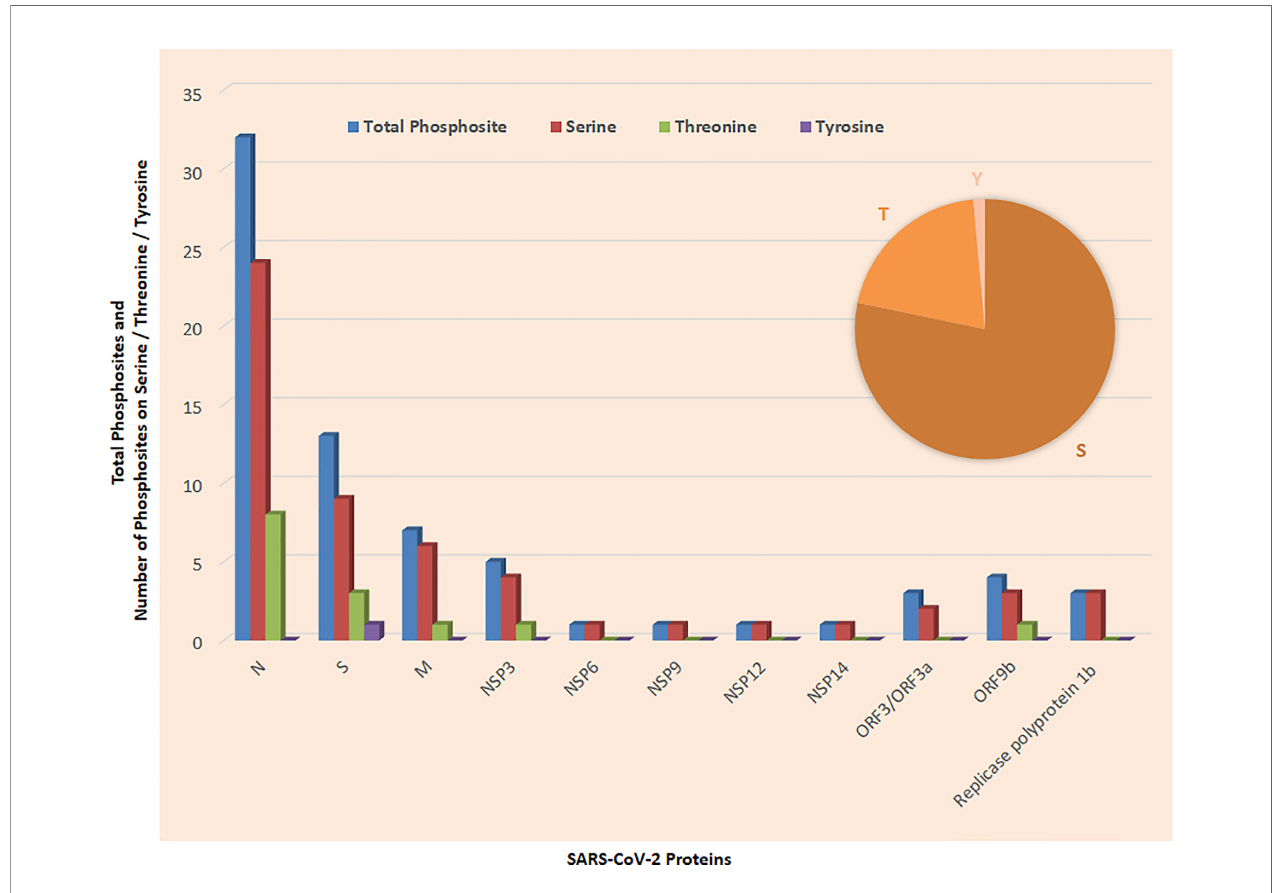
FIGURE 2 | Phosphosites detected in SARS-CoV-2 proteins; inset shows phosphosites on Serine (S), Threonine (T), and Tyrosine